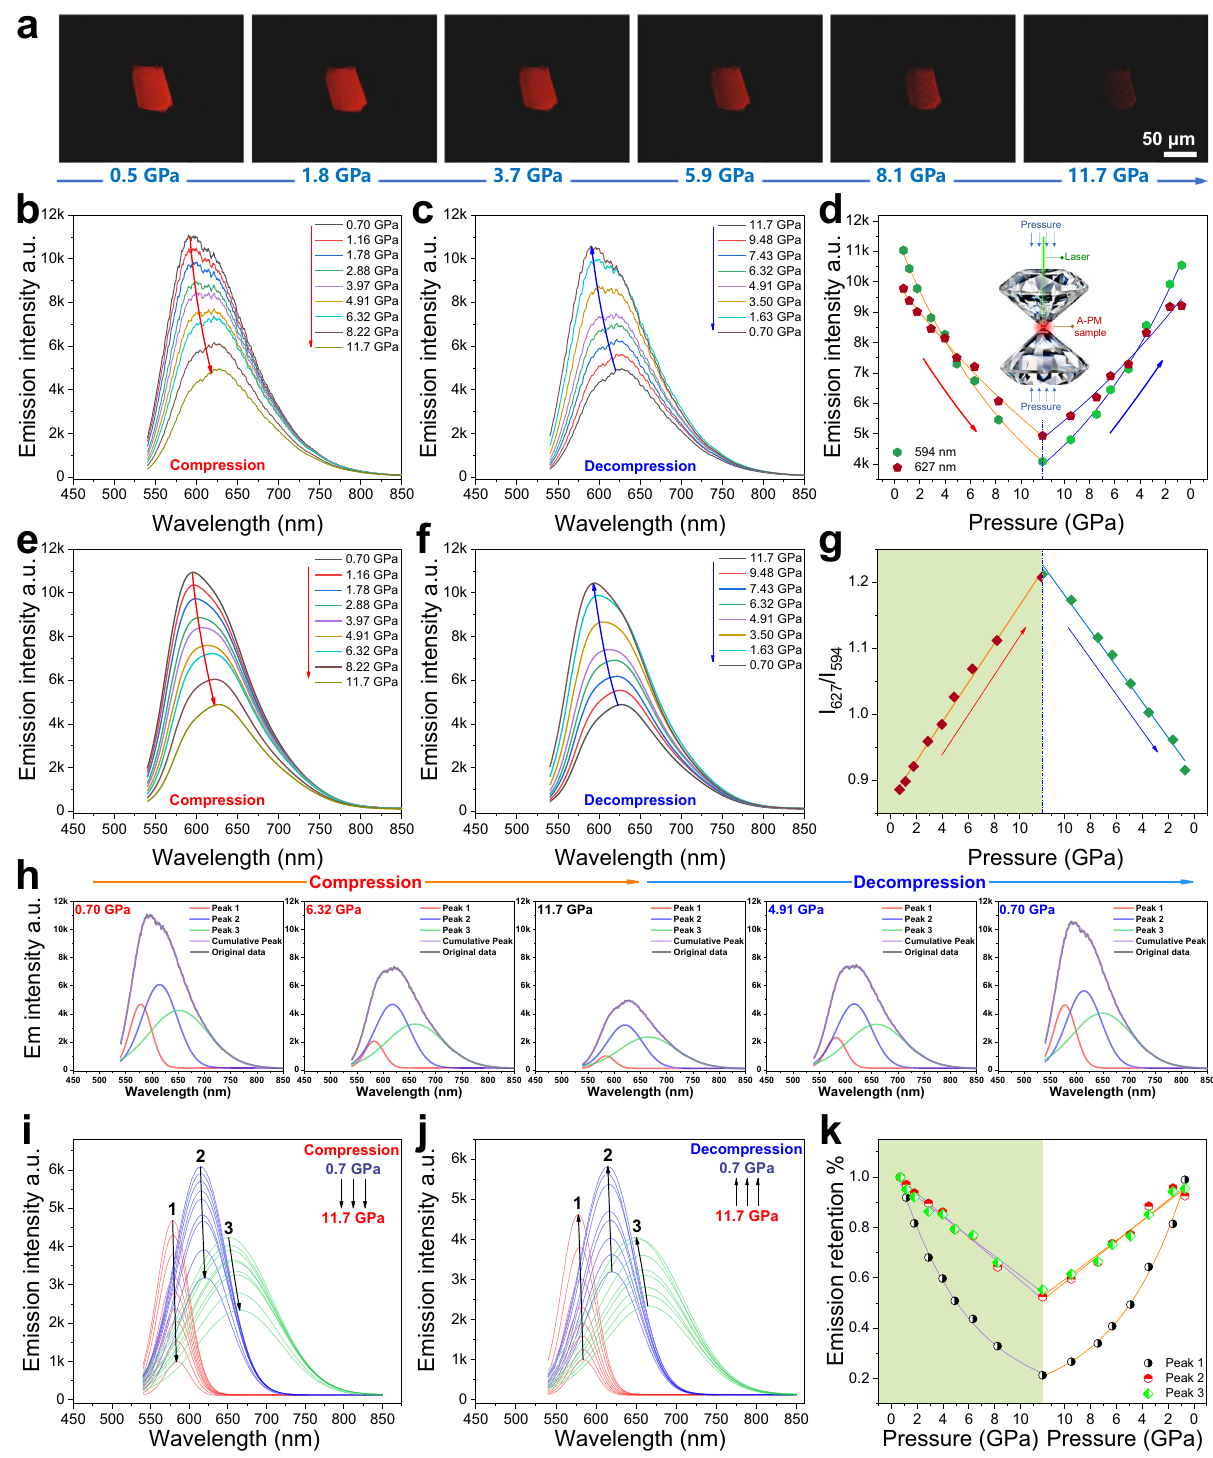
Fig. 4 Pressure-dependent fl uorescent properties of A-PM. a In situ fl uorescent images of A-PM-TEA compressed by different pressures. b , c , e , f Emission spectra and the multi-peak fi tting plots of A-PM-TEA during compression (0.70 – 11.70 GPa) and decompression (11.70 – 0.70 GPa). d , g Emission intensities at different wavelengths (594 nm, I 594 ; 627 nm, I 627 ) and their ratio I 627 / I 594 under different hydrostatic pressures. h – k Multi-peak fi tting analysis, the peaks separated from the emission spectra of A-PM-TEA and the intensity variation of the peaks during compression and